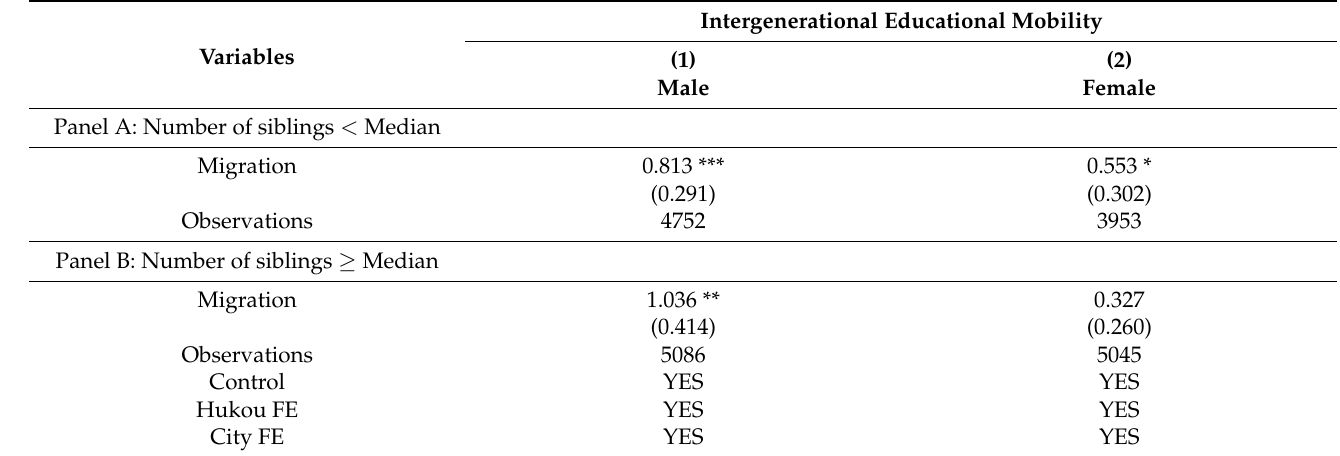
Table 5. Sibling crowding